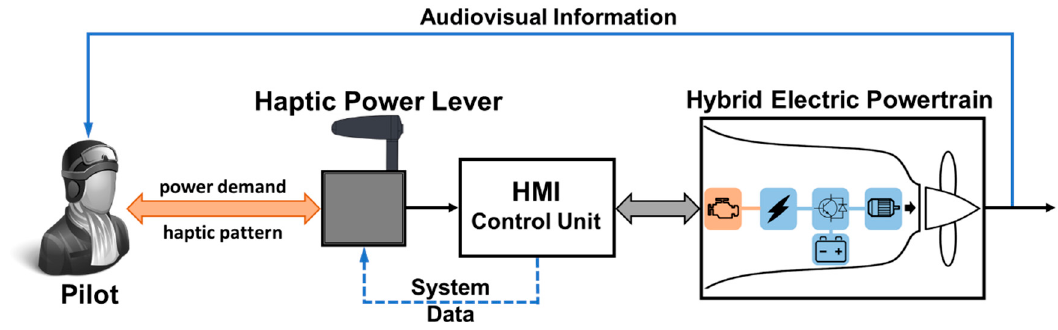
Figure 3. Pilot feedback involves audiovisual information and haptic information delivered by the force feedback of the haptic power lever.